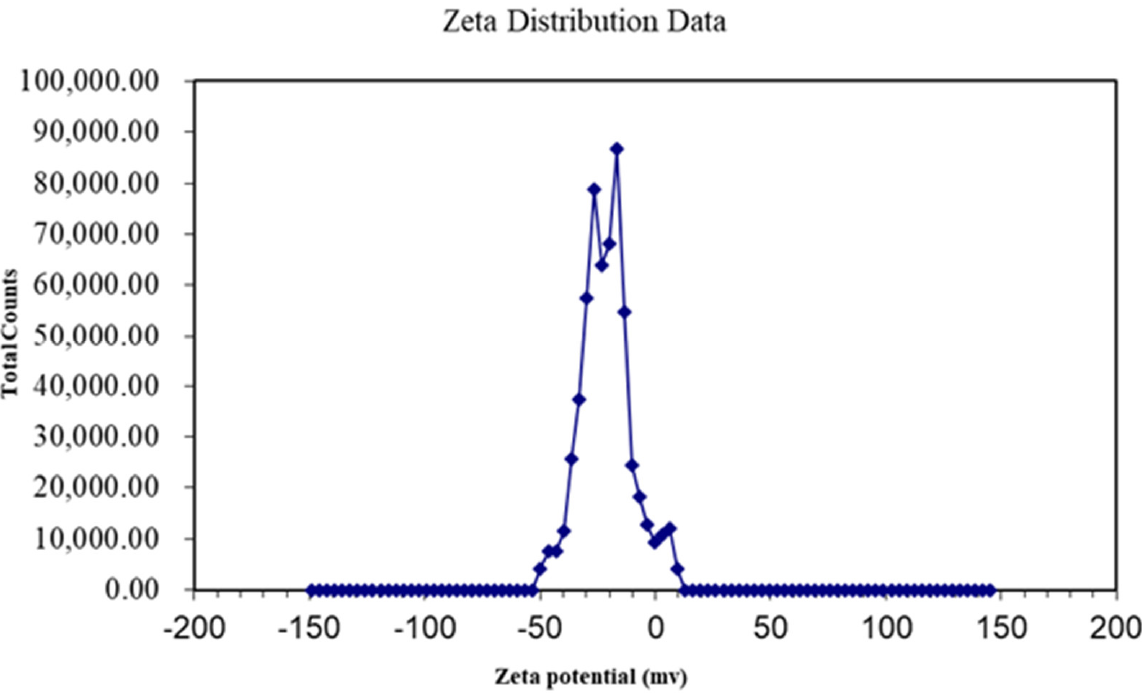
Figure 2. Zeta potential of GO dispersion.